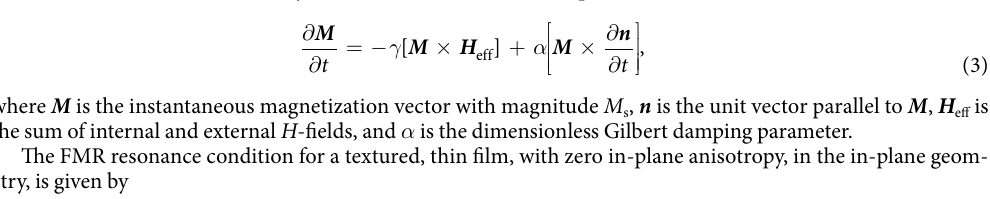
The plot of eq. (2) using M sPy and M sFe from SQUID are shown as black solid line on Fig. 2. Ferromagnetic Resonance. Magnetization dynamics of a thin magnetic film, undergoing ferromagnetic reso- nance (FMR), are well described by the Landau-Lifshitz-Gilbert equation,